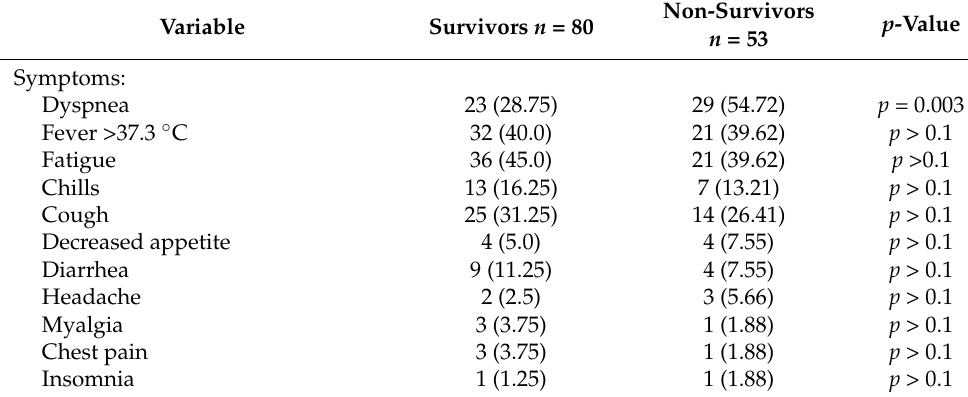
Table 3. Pattern of presenting symptoms, and laboratory findings on hospital admission in survivors and